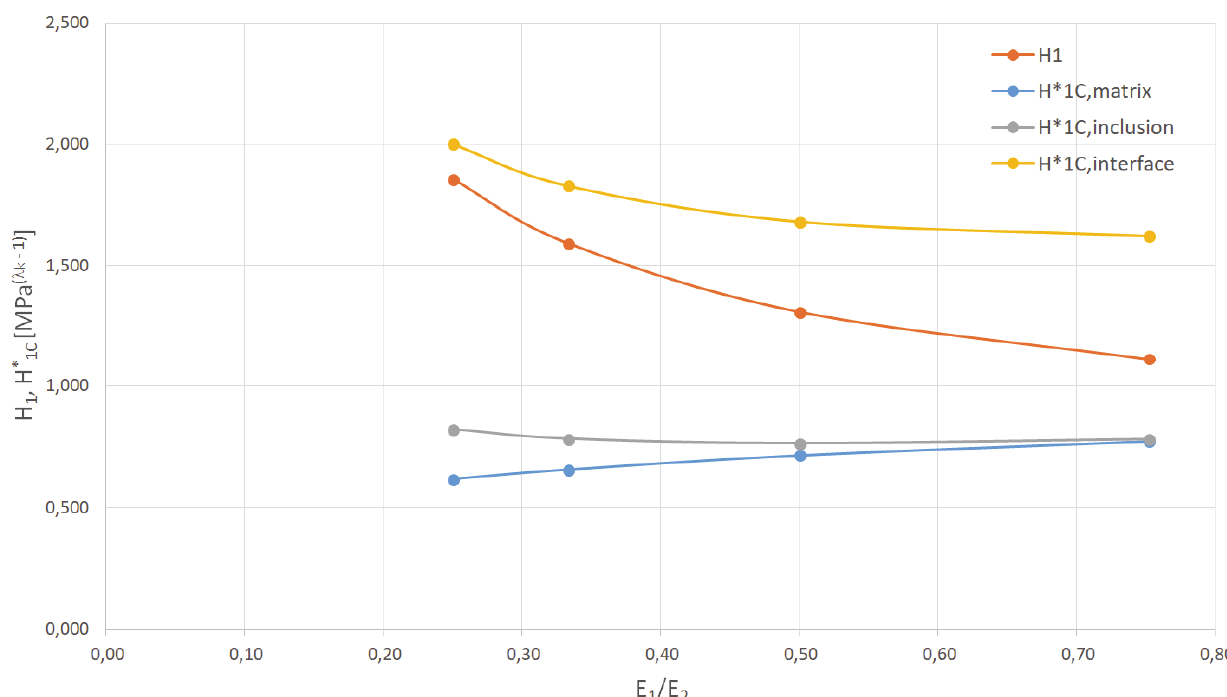
Figure 5: GSIF H 1 for unit applied load and the critical values H 1C needed for crack initiation to matrix and to the inclusion.